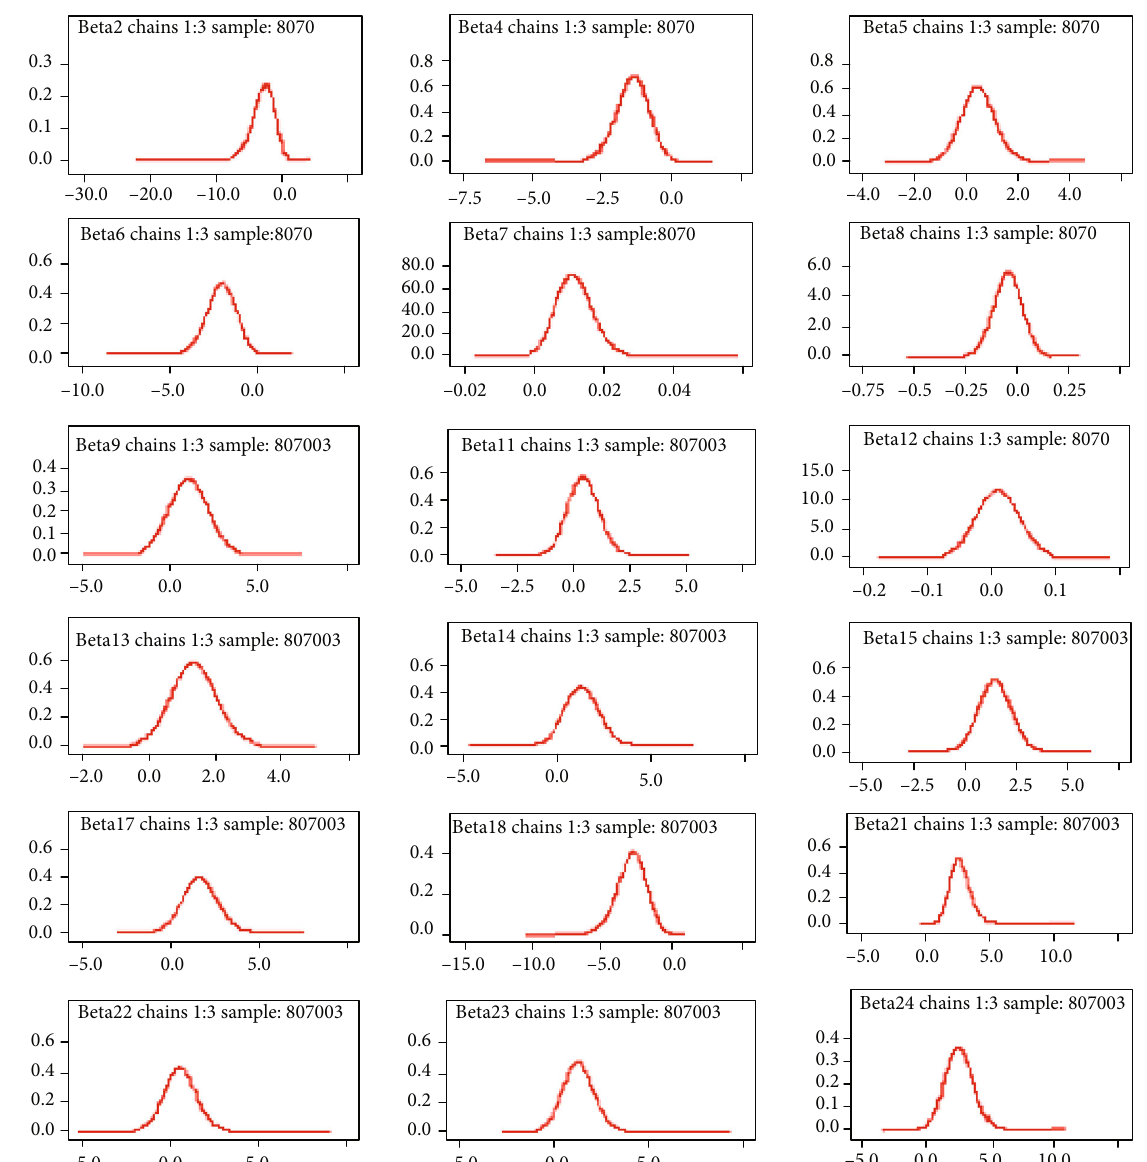
Figure 2: Density plot for convergence of coe ffi cients for the